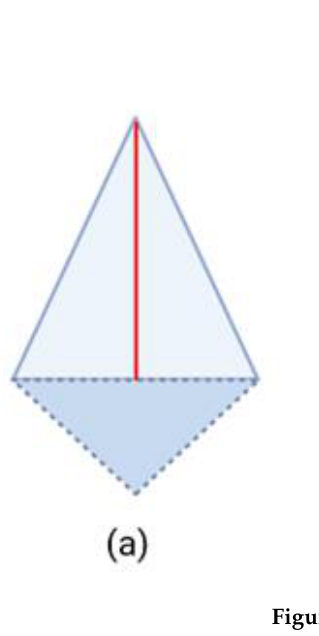
Figure 2. Triangle classification. ( a ) Type one; ( b ) type two; ( c ) type three. The skeleton line can be extracted using the classical CDT method for extracting the skeleton line of a vector building. According to the triangle connection method, for every type three triangle in the triangulation, the skeleton line extraction result is expected to have an additional branch, marked in the Figure 3 by the black solid line. However, buildings have few actual branches. Yan [35] abstracted a series of template shapes according to the shape characteristics of the building using common English letters (E, F, L, T, I, and C) and other shapes for building simplification. Furthermore, a building typically has right-angle features, and the skeleton line has few branches. Therefore, the traditional CDT-based skeleton line extraction algorithm is effective for extracting regular graphics. Irregularly processed vector buildings have many noise points, thus, the skeleton line extracted directly using this algorithm has many branches.